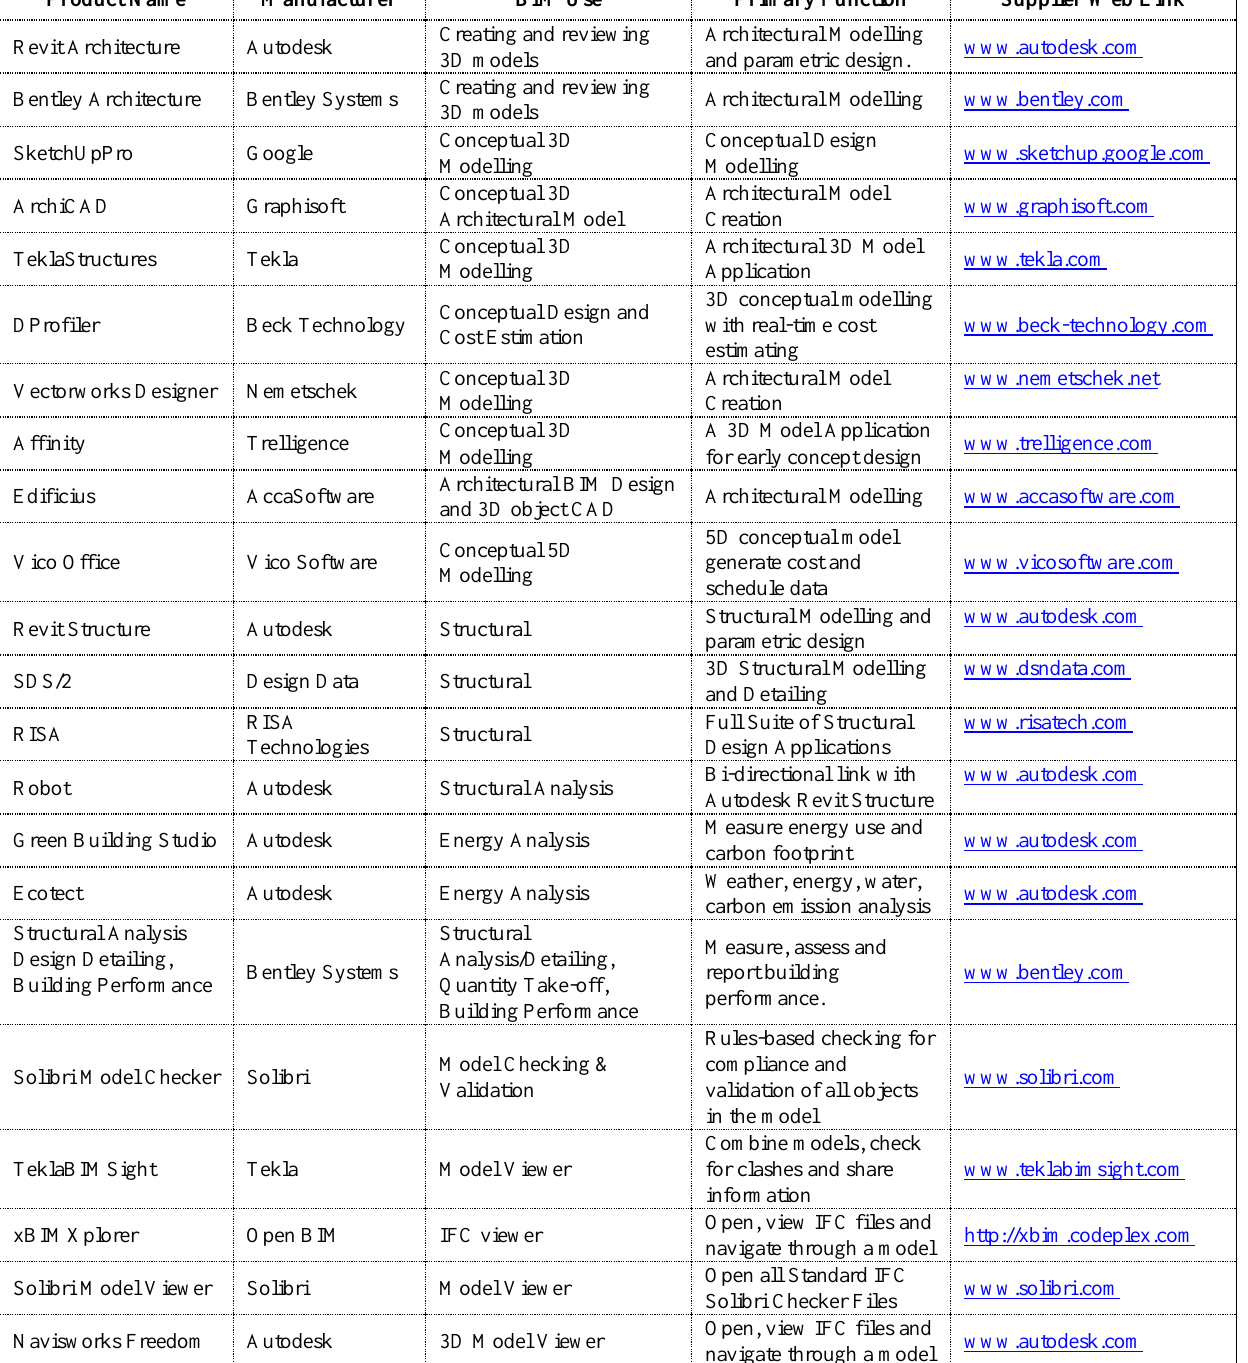
Table 1. Commercial and open source BIM